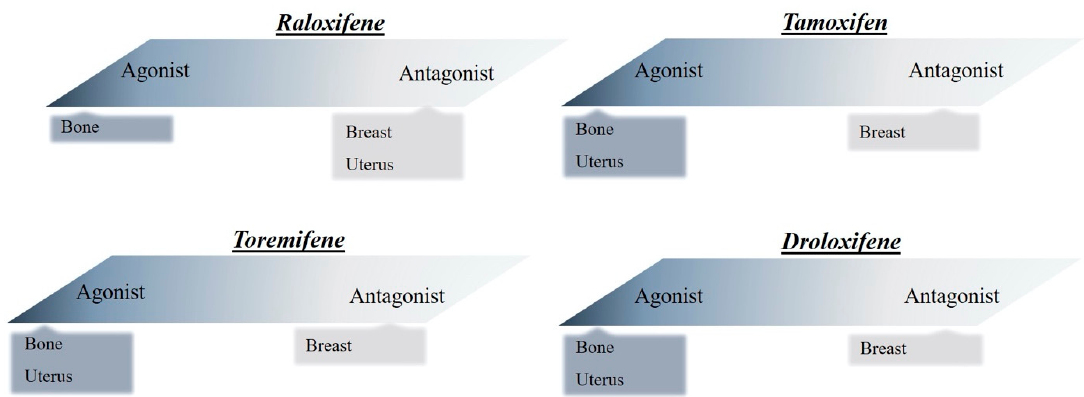
Figure 1. Agonist and antagonist effects of SERMs (raloxifene, tamoxifen, toremifene, droloxifene) in different tissues.